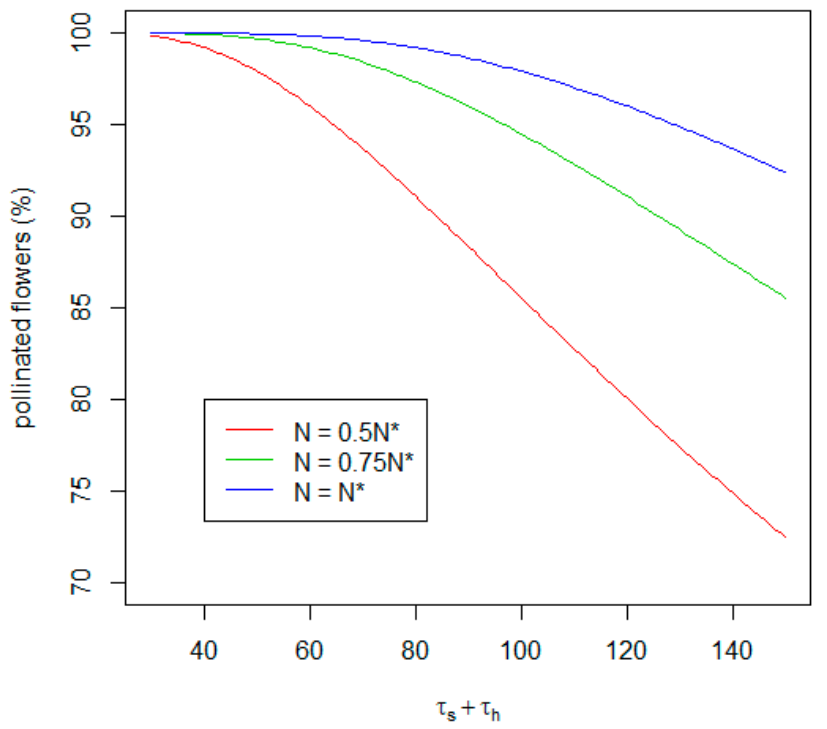
Figure 2. The time duration τ s + τ h of the pollination of a flower in nonlinear way determines the pollination success. The parameters are the following: T = 6 × 60 × 60 s, M = 700,000, N = c N *, where c = 0.5 (red), 0.75 (green), 1 (blue).